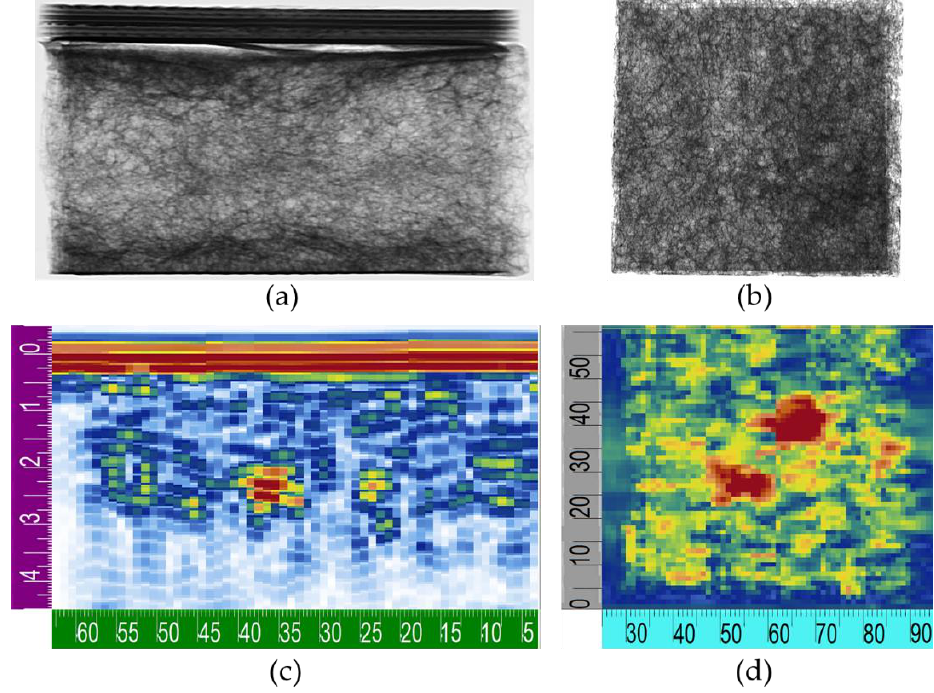
Figure 14. ( a , b ) Radiographic and ( c , d ) UPA inspections for Type V specimen subjected to an impact of 35 J.